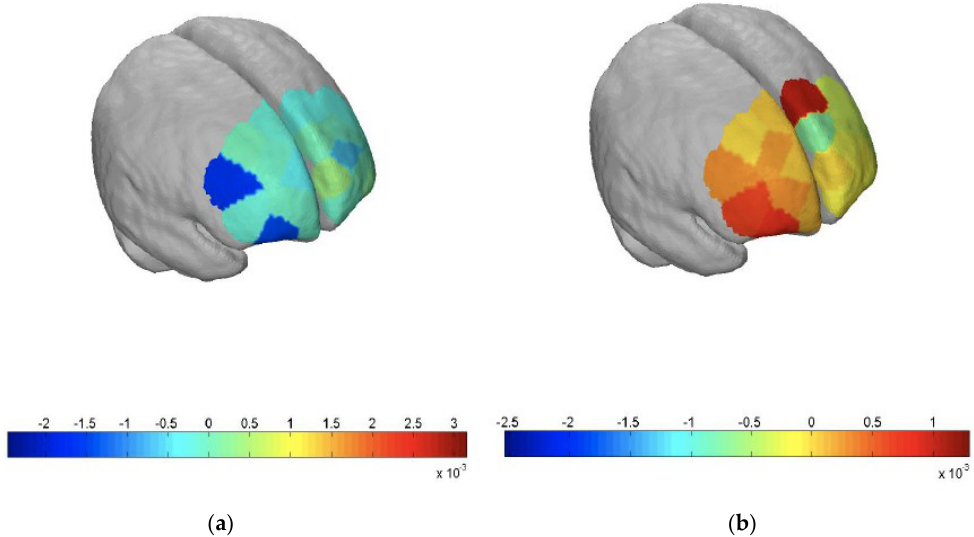
Figure 1. Functional near-infrared spectroscopy (fNIRS) imaging of the frontal lobe. The paradigm used in the imaging was the verbal fluency test (VFT), which required the individual to list as many words as possible that started with specific letters of the alphabet. The VFT is a short test of verbal functioning with involvement of the frontal lobe. The figure shows ( a ) areas of deactivation in the frontal lobe (highlighted in blue) in the patient compared with ( b ) areas of activation (highlighted in red) in an age- and gender- matched control, illustrating a frontal lobe impairment in chronic Mn toxicity.